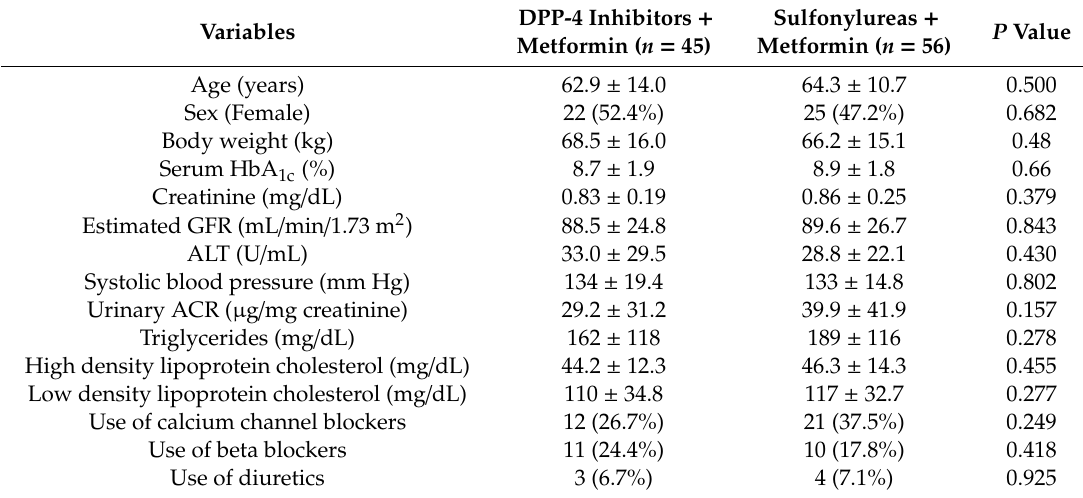
Table 1. Demographic features of participants at diagnosis of type 2 diabetes mellitus.